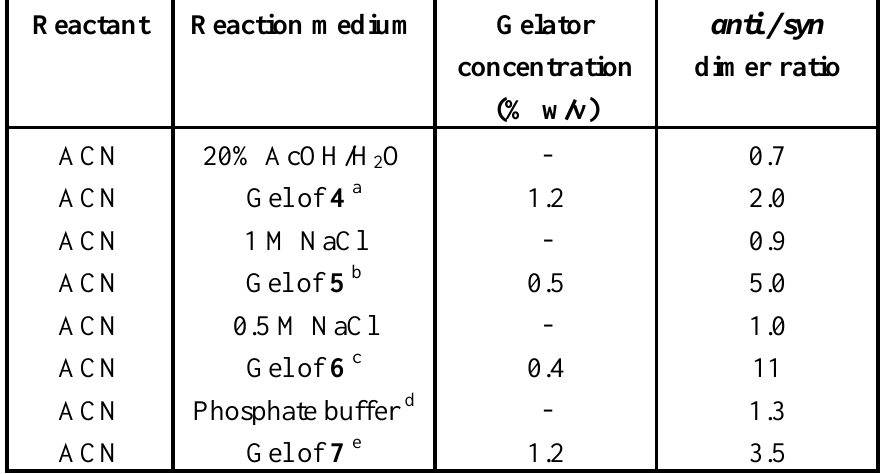
Table 1: Results obtained from acenaphthylene dimerization reaction in different hydrogels.